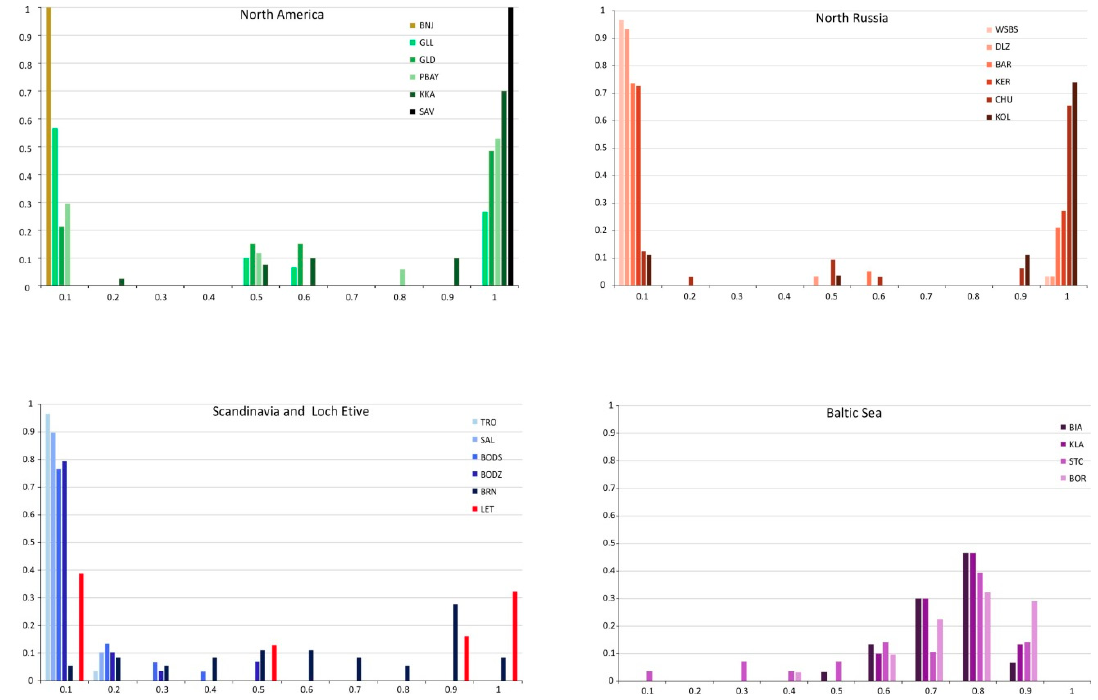
Figure 5. Frequency distribution of the score for a hybrid index giving the percentage of M. trossulus characteristic alleles. A score of zero is a pure M. edulis , whereas a score of one is a pure M. trossulus . Analysis was presented for four groups of populations: North America, North Russia, Scandinavia with Scotland and Baltic Sea. See Table 1 for definition and abbreviations.